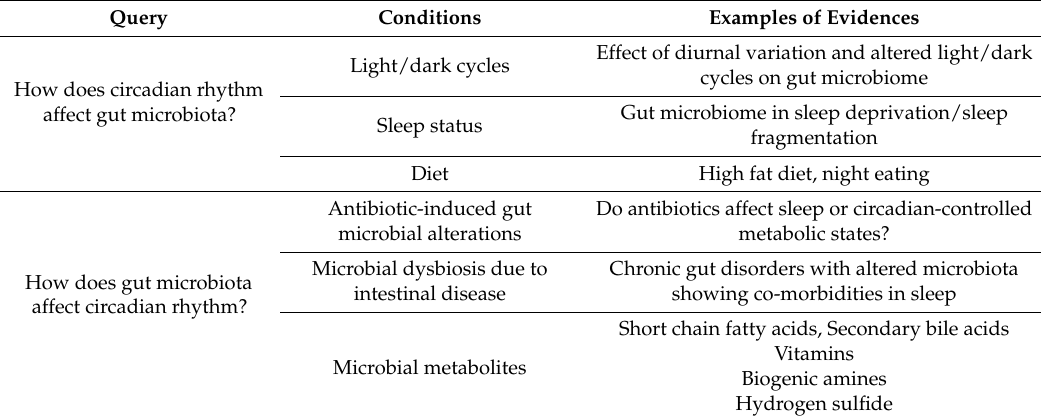
Table 1. Guiding queries used to examine gut microbiome–circadian